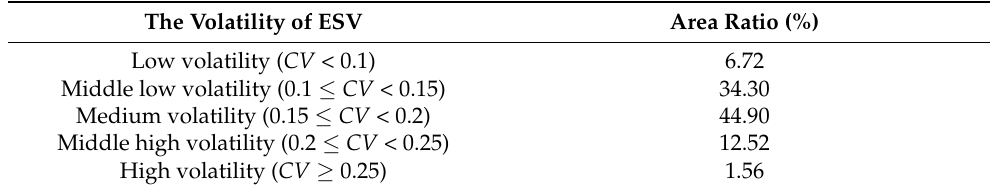
Table 5. Area ratio with different volatility level of grassland ESV in Inner Mongolia from 2000 to 2019.